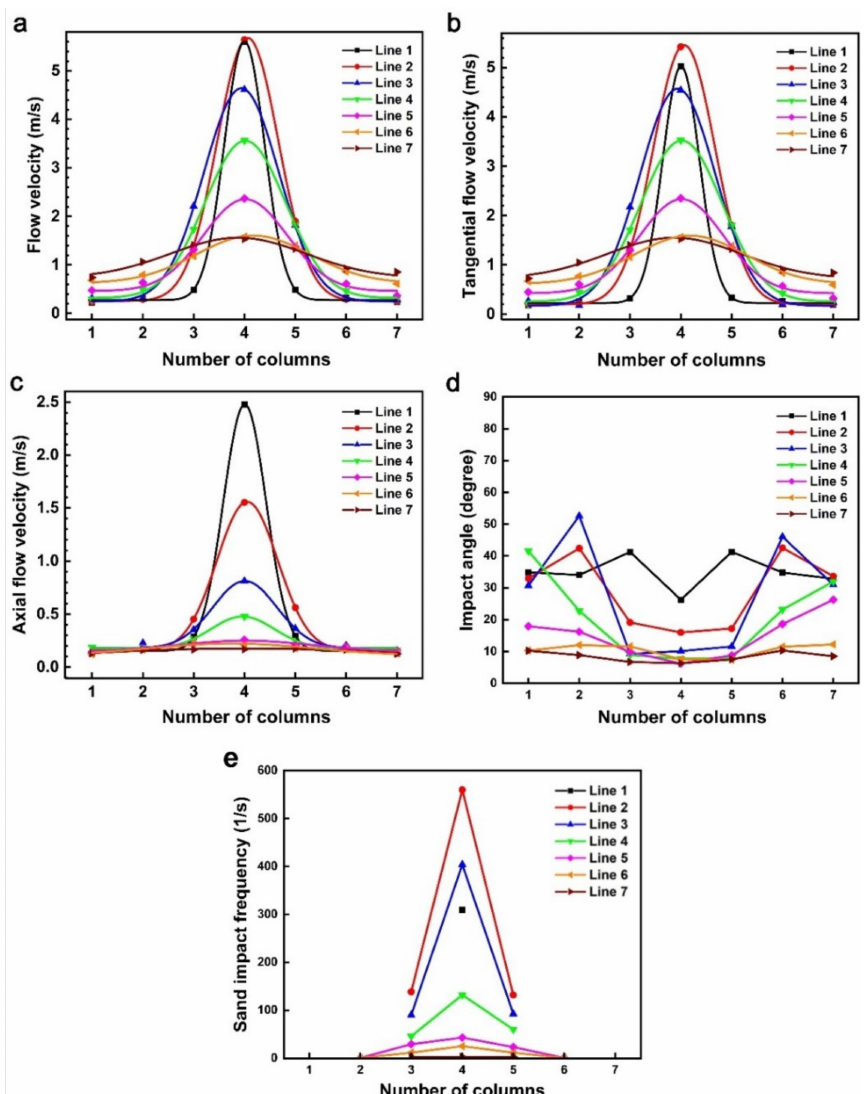
Figure 6. Calculated ( a ) total flow velocity, ( b ) tangential flow velocity, ( c ) axial flow velocity and ( d ) impact angle, and the obtained ( e ) sand impact frequency on the surface of each wire in the WBE obtained from CFD